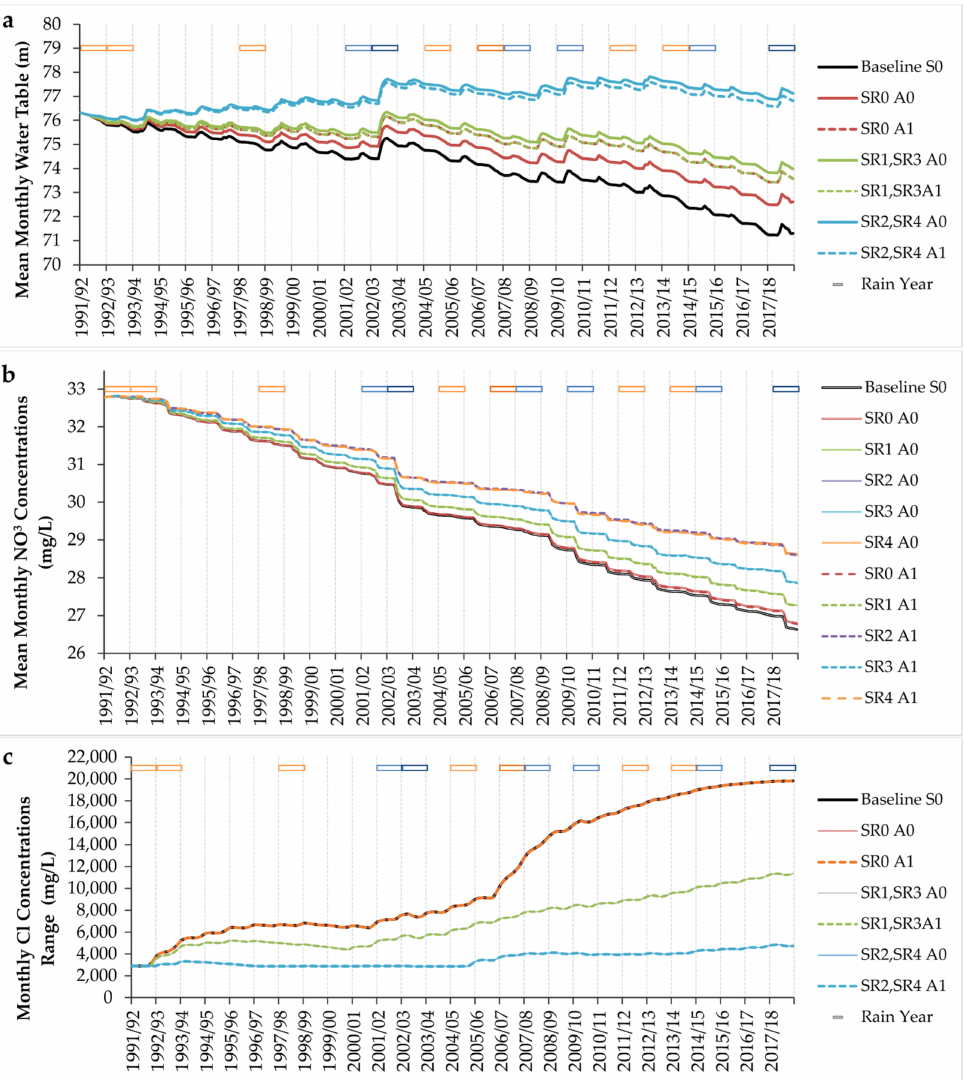
Figure 12. Monthly values of ( a ) Mean Water Table Elevation (m), ( b ) Mean Nitrates concentration (NO 3 − ) (mg/L), and ( c ) Chlorides Concentration (mg/L) of Almyros aquifer for the period